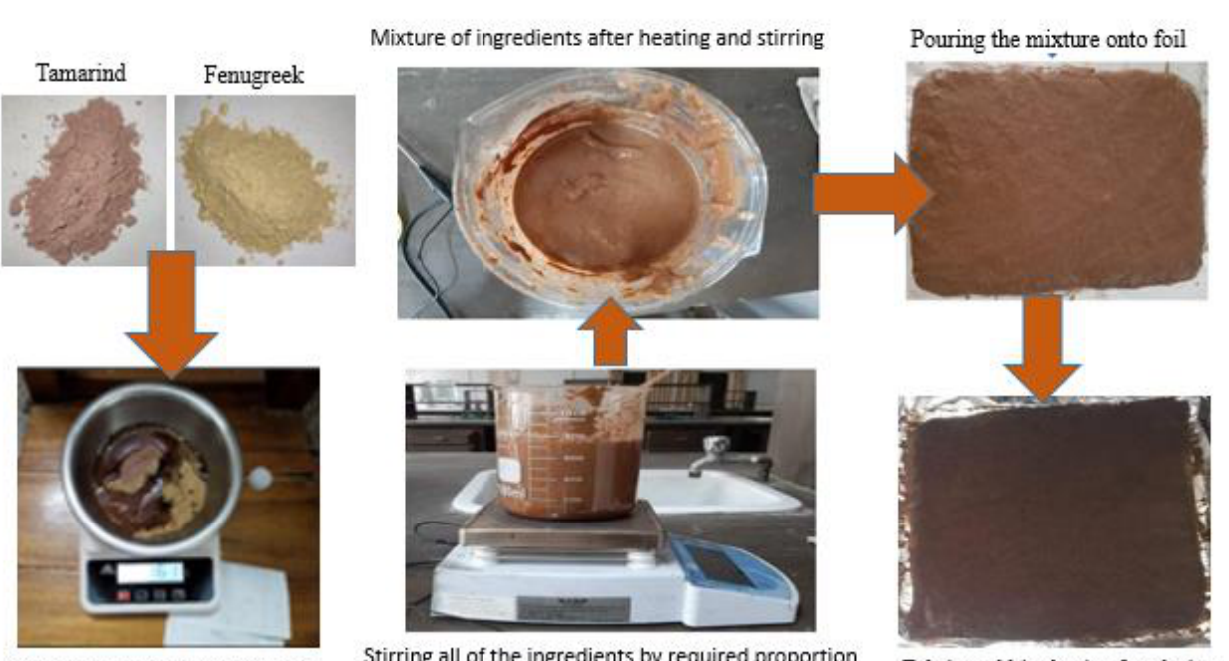
Figure 1. Bio-composite preparation from the natural sources. Table 3. The used constituents with their percentages.